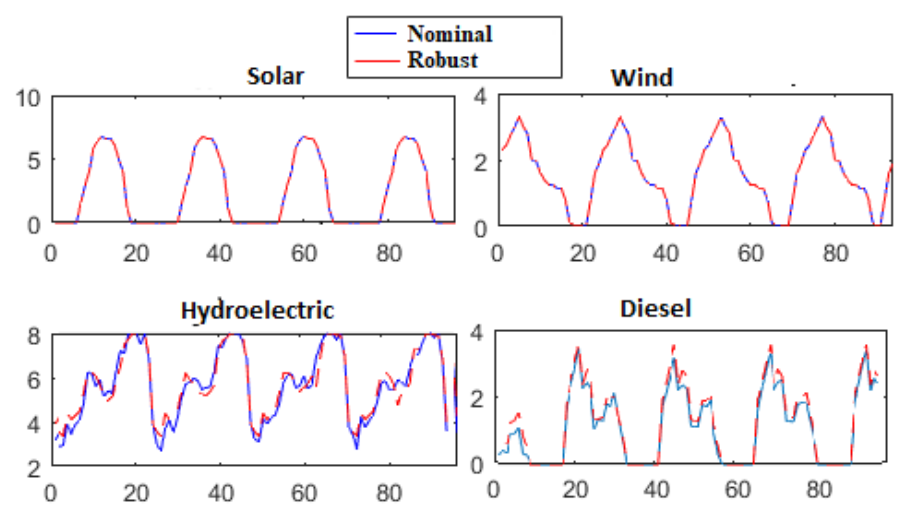
Figure 5. Sample summer plots of energy production.